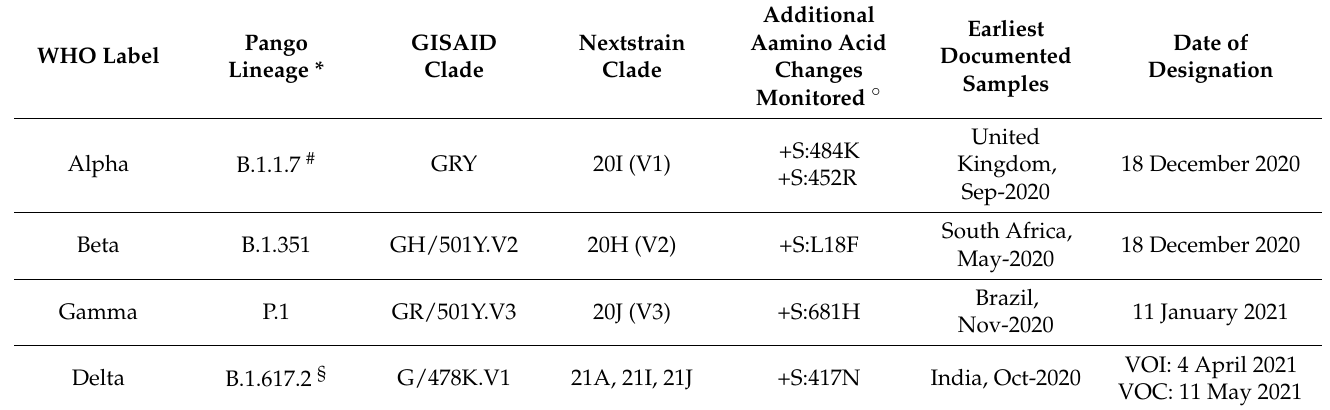
Table 3. Currently designated Variants of Concern (VoC) [63].